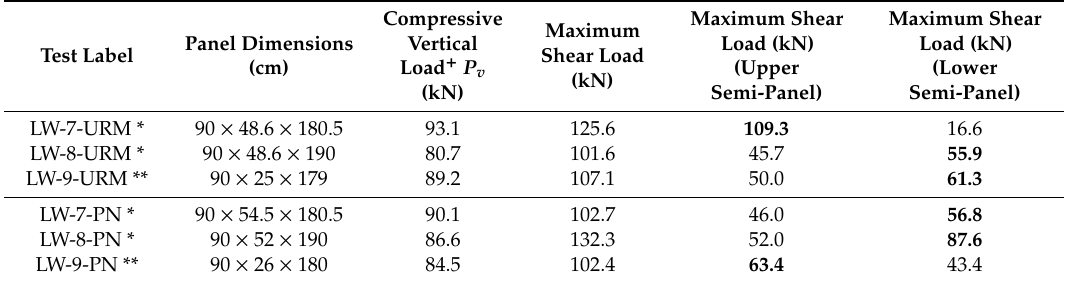
Table 6. Results of shear tests (LW panels); the results are in terms of the in-plane load capacities.